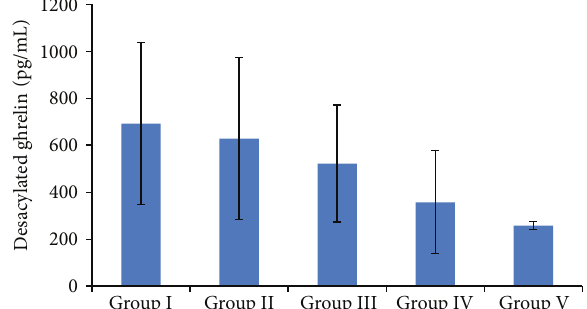
Figure 2: Serum desacylated ghrelin levels in relation to BMIs. Group I: low-weight; Group II: normal-weight; Group III: over- weight; Group IV: obese; Group V: morbidly obese. 𝑃 < 0.005 for Group I versus Group II versus Group III versus Group IV and Group